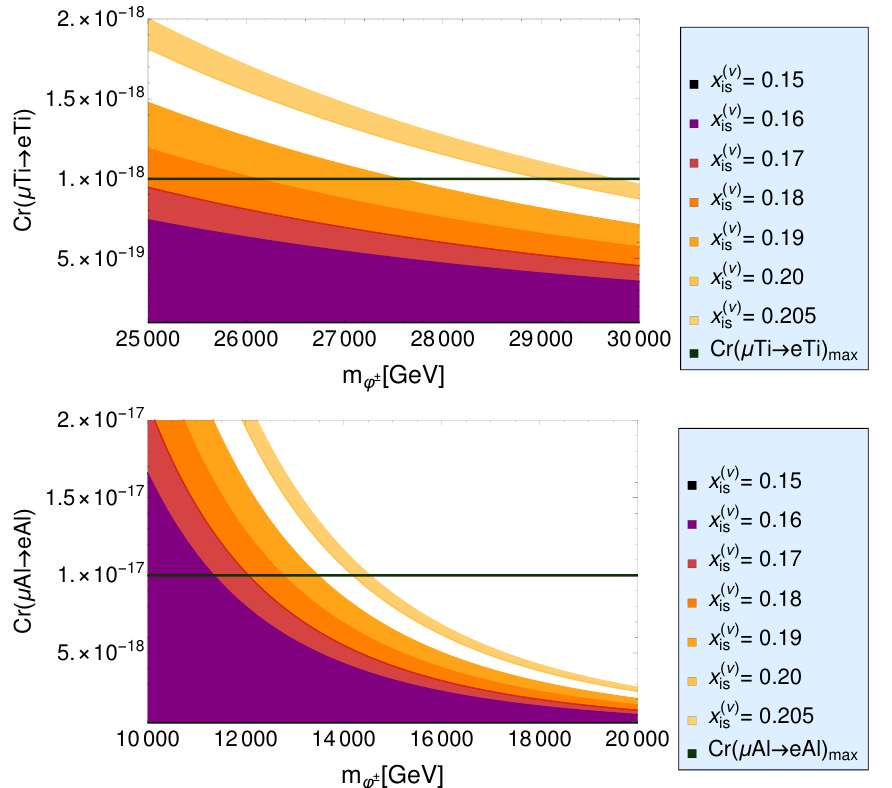
Figure 5 . CR ( µ Ti → e Ti ) (top plot) and CR ( µ Al → e Al ) (bottom plot) as function of the charged scalar masses m , for different values of the x ( ν ) couplings ( j = 1 , 2 , 3 , n = 1 , 2 ). The black ϕ ± js horizontal line in each plot corresponds to the expected sensitivities of the next generation of experiments that will use titanium [173] and aluminum [171] as targets, respectively. Here we have set m N = 50 MeV.